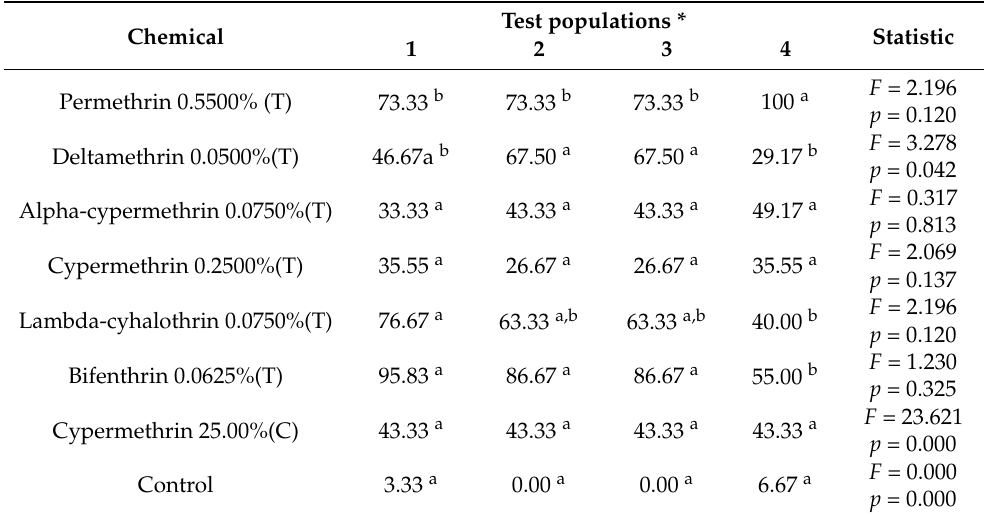
Table 4. Comparison of the mean number of pyrethroid insecticide responses (mortality rates at 24 h after insecticide exposure) of the four populations of stable flies (1 = Stomoxys calcitrans SON; 2 = Stomoxys calcitrans PHA; 3 = Stomoxys indicus PHA; 4 = Stomoxys indicus SAT). Test populations * Statistic Chemical 1